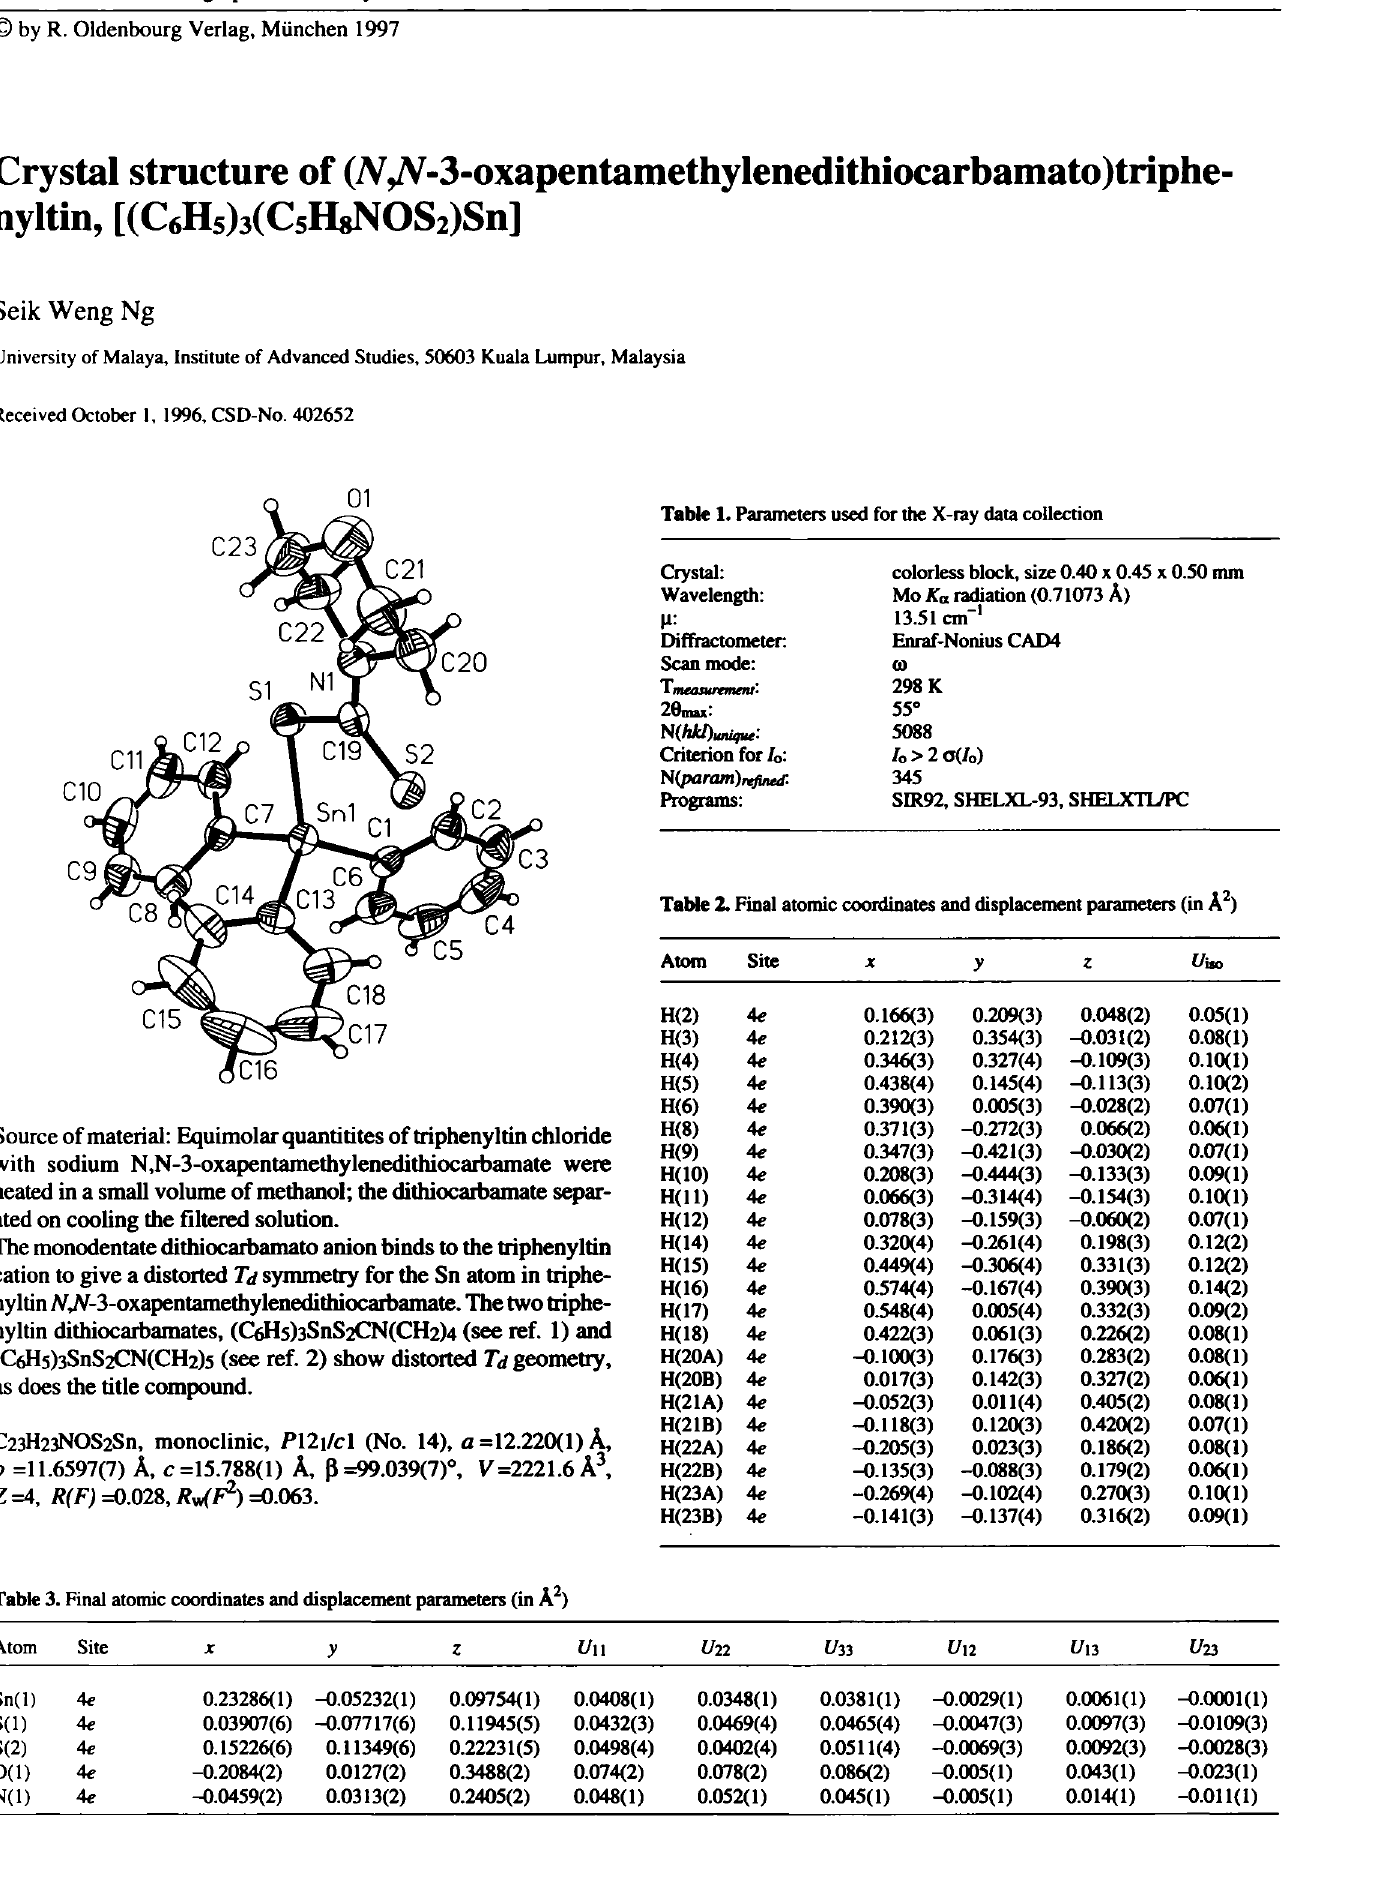
Table 3. Final atomic coordinates and displacement parameters (in Â 2 )